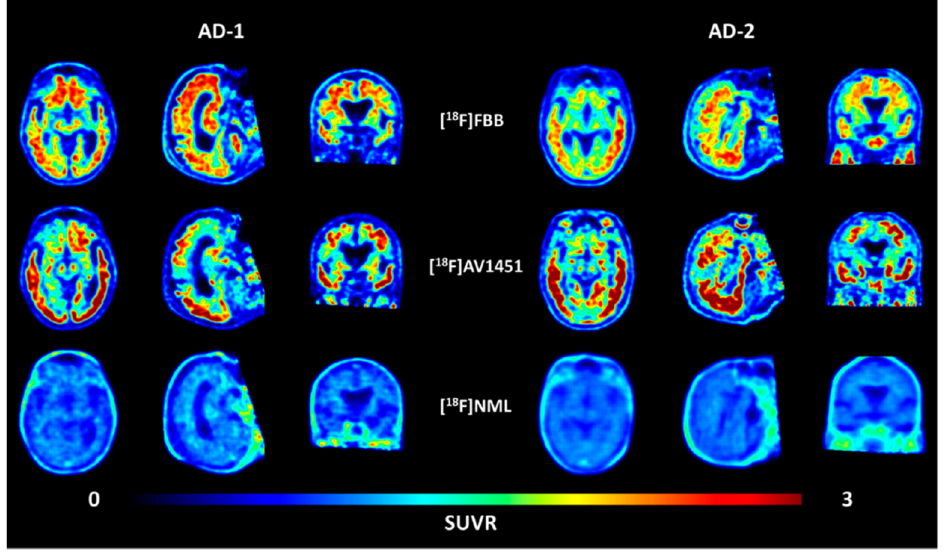
Figure 7. Transversal, sagittal, and coronal view of averaged PET images of [ 18 F]AV1451 and [ 18 F]NML uptake in two AD patients 90–110, 80–100, and 60–90 min p.i., respectively. (Images taken from reference